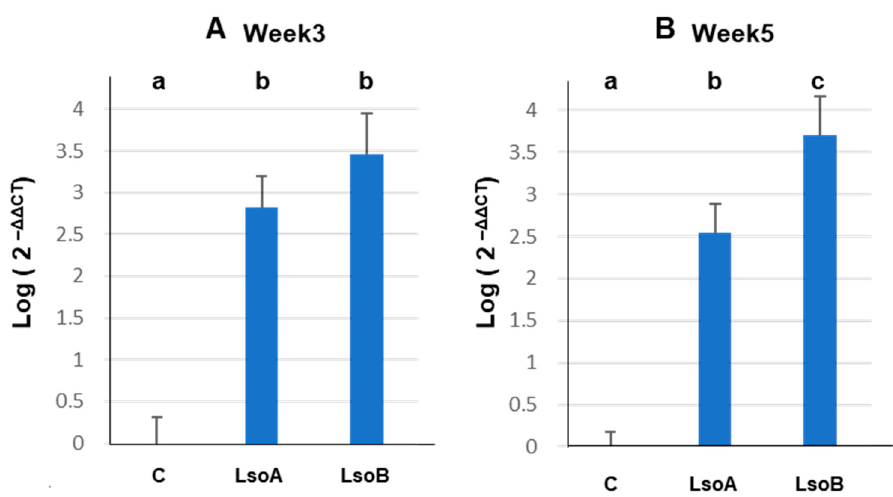
Figure 3. PR1a relative expression at ( A ) 3 weeks and ( B ) 5 weeks after infection. PR1a relative expression was quantified using RT-qPCR and analyzed using the ΔΔ Ct method using β -Actin as the housekeeping gene control and the uninfected sample as a reference. Bars represent mean ± SEM fold change relative to uninfected plants. Dif- ferent letters (a, b and c) indicate significant differences in gene expression as determined by Kruskal-Wallis analyses followed by pairwise comparisons using Wilcoxon with p -val- ues adjusted with the Benjamini-Hochberg method ( p < 0.05). The fold change in the Y- axis is in the log scale. C is for uninfected control, LsoA is for LsoA-infected, and LsoB is